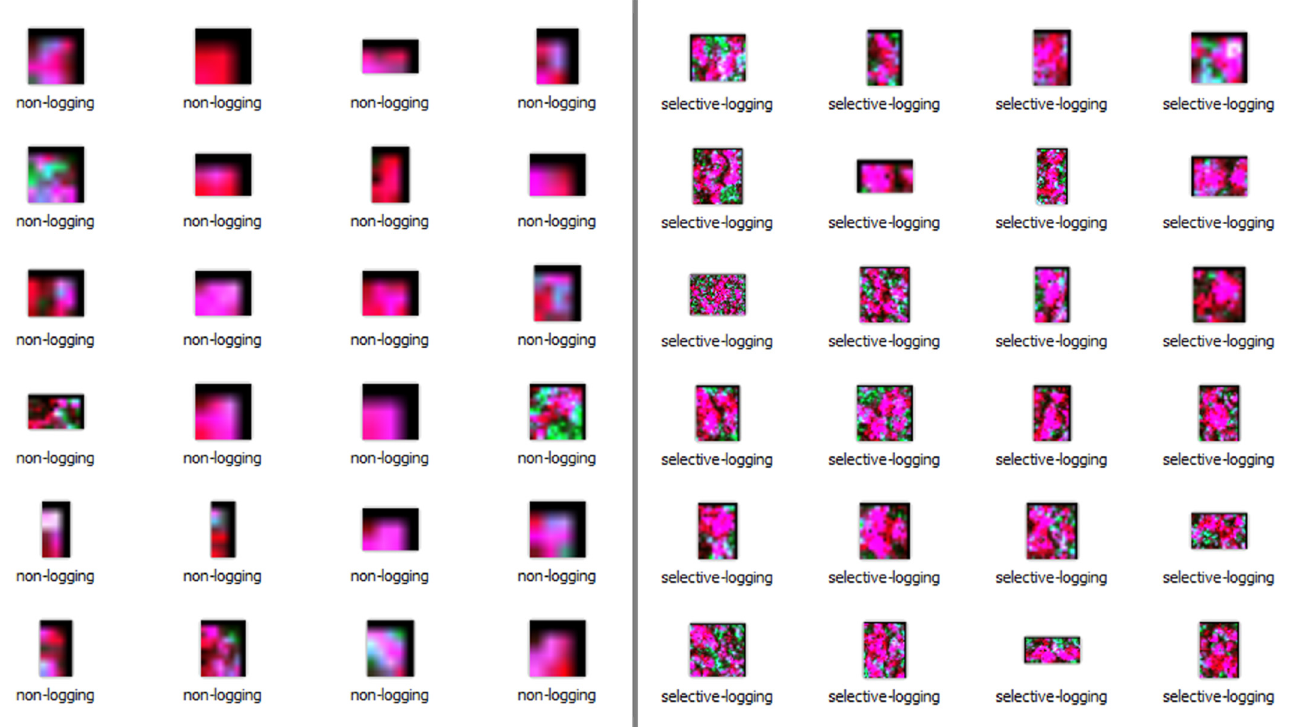
Figure 3. Selective logging and non-logging covmingrad subimages used for CNN training.